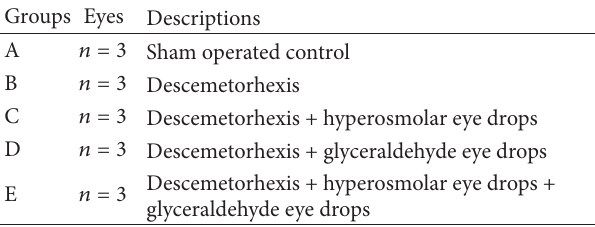
Table 2: Characteristics of 15 rabbits in central corneal thickness (CCT) and corneal transparency